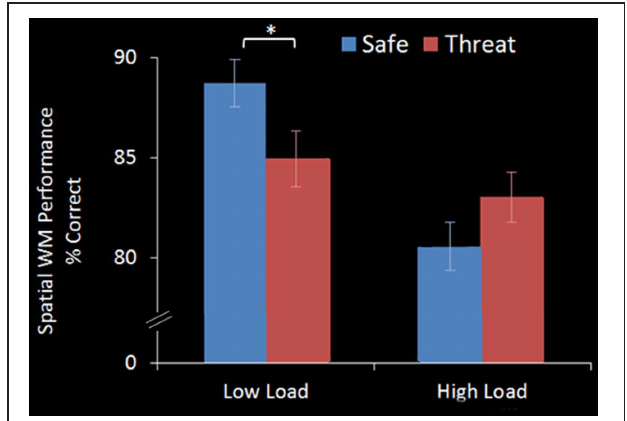
FIGURE 2 | WM accuracy in the emotional top-down control task. In the Low Load condition (2-back) threat significantly interfered with performance, whilst in the High Load condition (3-back) there was no interference from threat. Error bars display within-subject standard error (Morey, 2008). ∗ p < 0 . 05